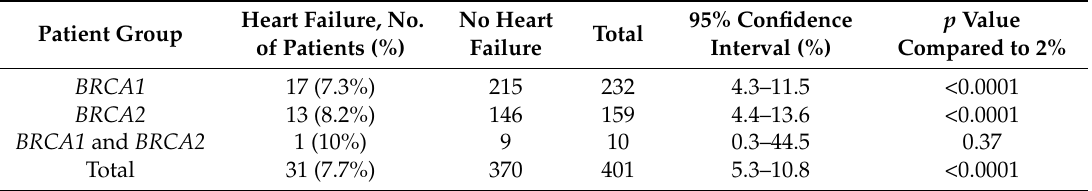
Table 2. Patients diagnosed with heart